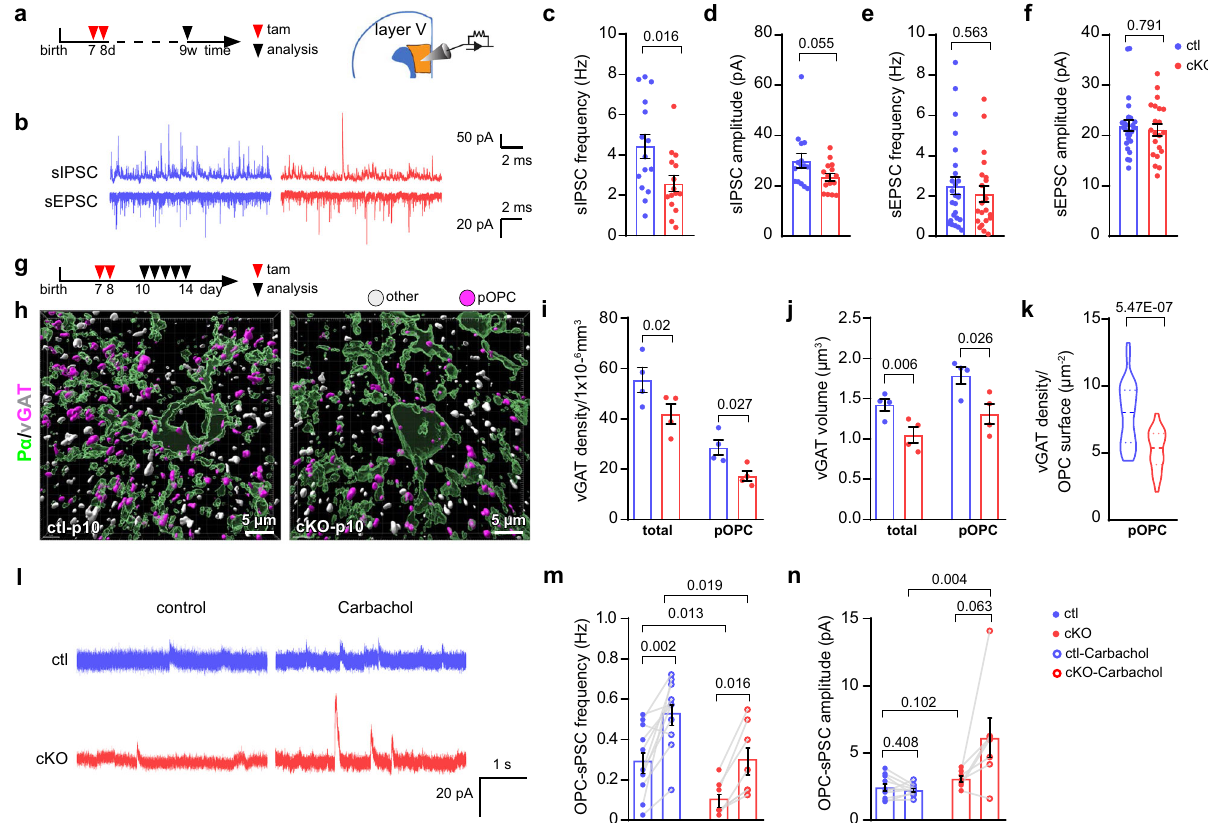
Fig. 3 Interneuron activity is impaired in the mPFC of OPC-GABA B R cKO mice. a Experimental schedule for b – f and the scheme of analyzed brain region (orange). b Patch-clamp recordings of sIPSCs and sEPSCs in pyramidal neurons of layer V of medial prefrontal cortex (mPFC). c – f Quanti fi cation of frequencies and amplitudes of spontaneous inhibitory and excitatory postsynaptic currents (sIPSC and sEPSC, respectively) (sIPSC: ctl = 15 cells from 4 mice, cKO = 15 cells from 5 mice; sEPSC: ctl = 26 cells from 4 mice, cKO = 21 cells from 5 mice; sIPSC frequency was analyzed with two-sided unpaired t - test, d – f : two-sided unpaired Mann – Whitney test). g Experimental schedule for h – n . h Surface renderings of OPCs and inhibitory presynapses based on PDGFR α (P α , green) and vGAT (vesicular GABA transporter, white and magenta) immunostaining in ctl and cKO mPFC at p10 using Imaris software. vGAT was classi fi ed into two subgroups: on putative OPC synapses (pOPC, magenta vGATs with less than 200 nm distance from the OPC surface) and other synapses (other, gray vGATs more than 200 nm). Density ( i ) and volume ( j ) of vGAT in ctl and cKO mPFC. (ctl = 4 mice, cKO = 4 mice; two-sided unpaired t -tests). k Quanti fi cation of synaptic vGAT (<200 nm) density per µ m 2 of OPC surface. (ctl = 4 mice, cKO = 4 mice, two-sided unpaired t -tests). l Patch-clamp recordings of spontaneous postsynaptic currents (sPSCs) of OPCs at the layer of V of mPFC at p11-14. m , n Quanti fi cation of sPSC frequency and amplitude of OPCs before and after addition of carbachol. (ctl = 11 cells from 3 mice, cKO = 7 cells from 3 mice, two-sided unpaired t -tests). Data are shown as mean ± SEM in c – f , i , j , m and n . In k , data are shown with indications of median and quartiles in thick and thin dashed lines, respectively. Source data are provided as a Source Data fi